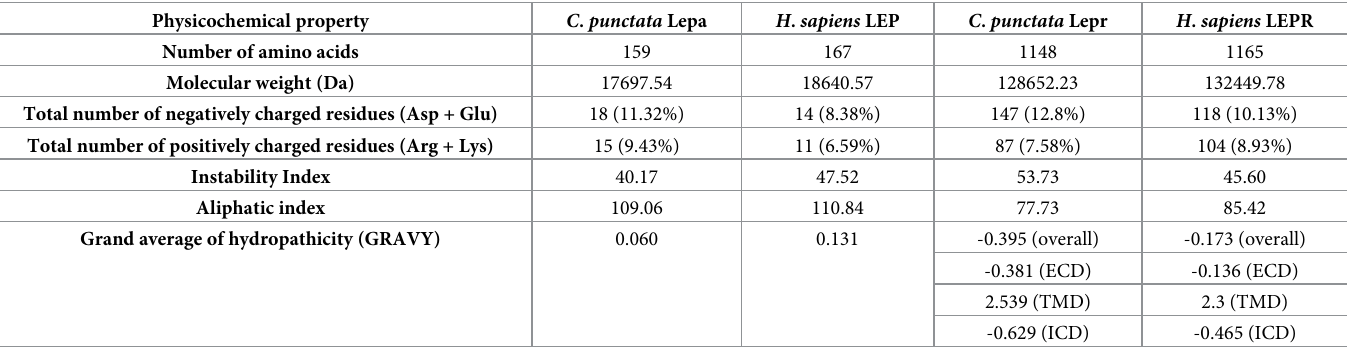
Lepa: leptin paralog a, Lepr: leptin receptor; ECD: extracellular domain, TMD: transmembrane domain, ICD: intracellular domain. Human orthologs were used as